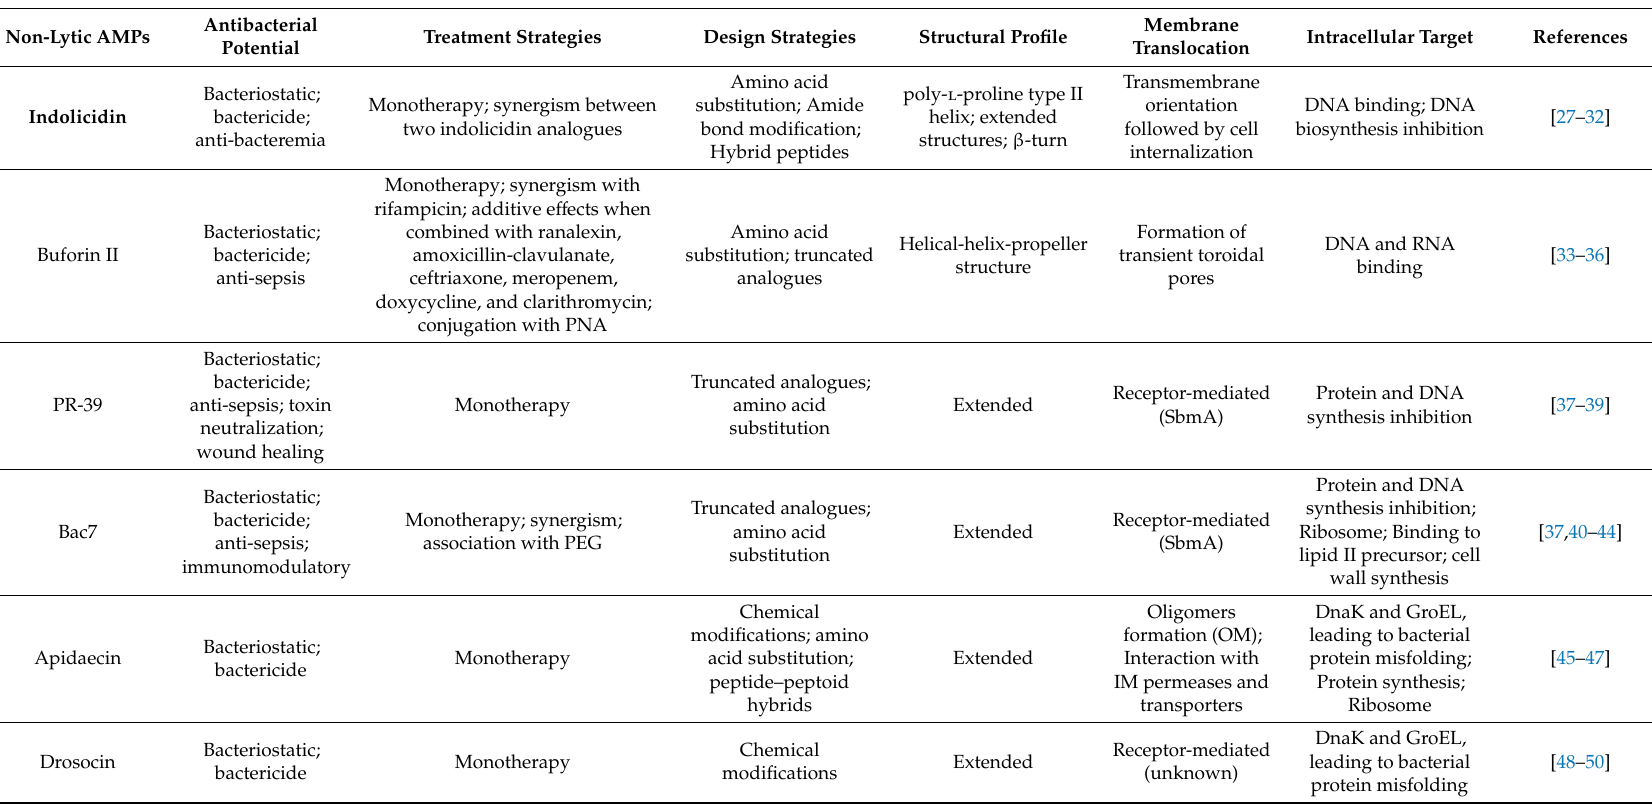
Table 1. Summary of the non-lytic AMPs here described in terms of antibacterial potential and applicability, the design strategies for the generation of improved analogues, structural profiles, modes of translocation across bacterial membrane and known intracellular